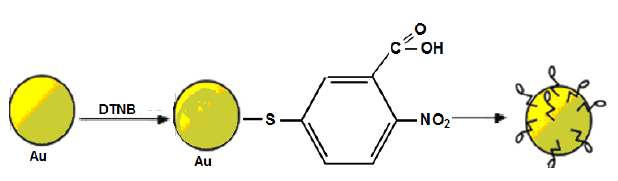
Figure 1: Scheme for preparation of Au-NP - DTNB conjugates.